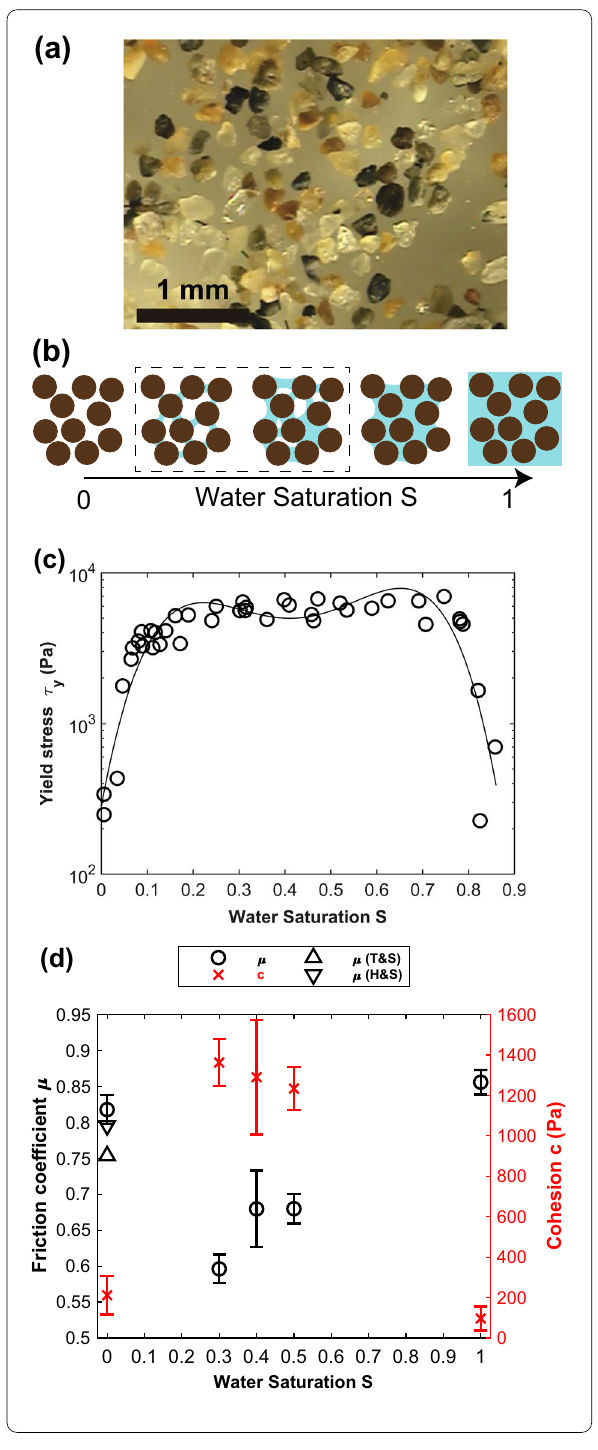
Fig. 1 a A photo of the sand particles used for the experiments. b A schematic diagram showing the structural change of the wet sand with increasing water saturation S . A box indicates the intermediate S (left: pendular, right: funicular) in which liquid bridges form. c Yield stress τ y versus S ( φ = 0.50 ± 0.02 ) of the wet sand obtained from vane rheometry. A curve is a fourth-order polynomial fit to ln τ y (Takita and Sumita 2013). d Friction coefficient µ ( (cid:31) : left axis) and cohesion c ( × : right axis) versus S of wet sand obtained from parallel plate rheometry (see Additional file 4: Table S1 for the values of µ and c ). The µ obtained from the angle of repose θ r of dry sand ( S = 0 ) is also plotted. (cid:31) : µ = 0.75 from a convex pile (Takita and Sumita 2013), (cid:31) : µ = 0.80 from a concave crater (Hayashi and Sumita